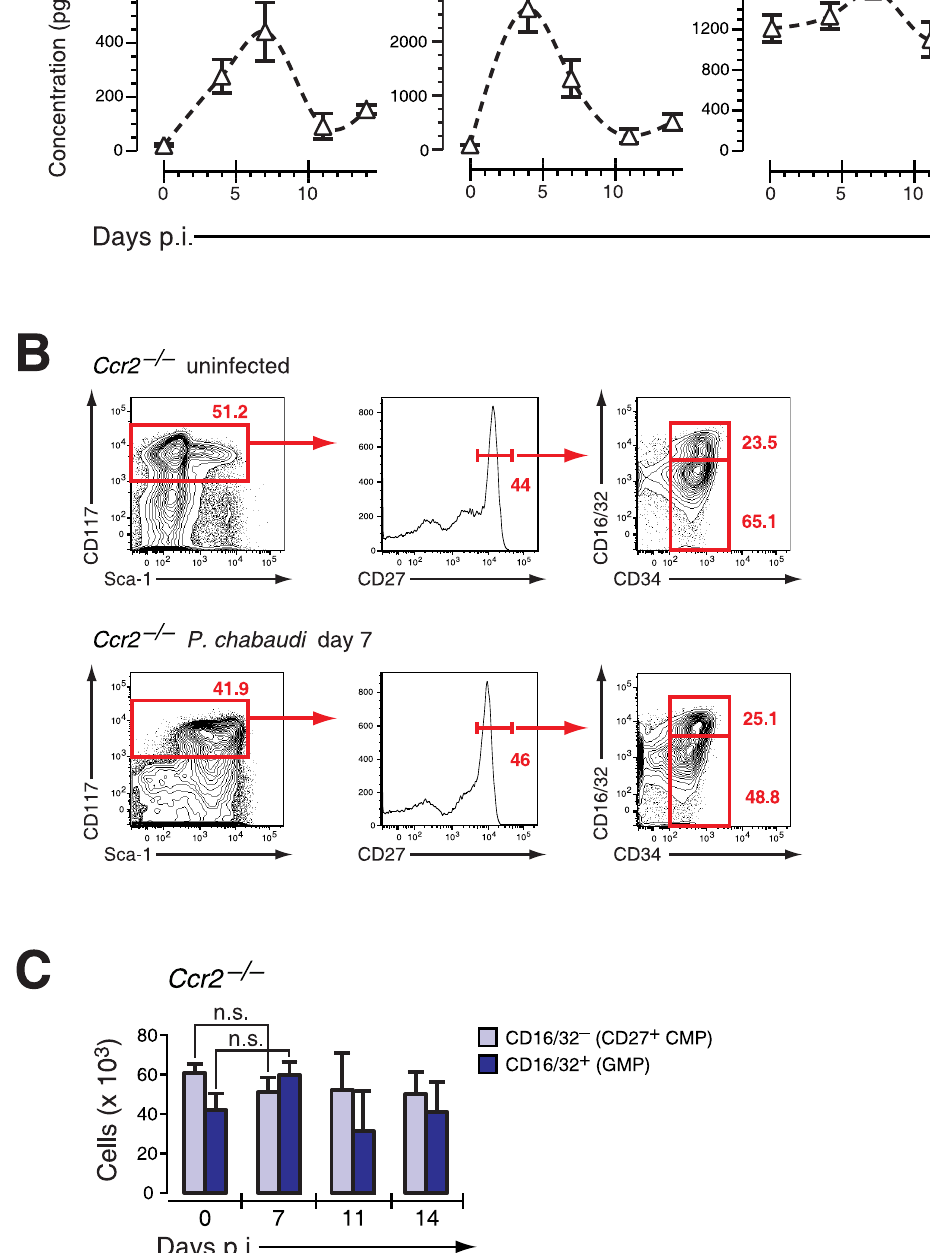
Figure 6. Ccr2 -null mice induce IFN- c -dependent chemokines but do not mobilize early myeloid progenitors. A. Serum concentration of IFN- c induced chemokines in Ccr2 -null mice infected with P. chabaudi . Data are shown as mean 6 SEM of serum concentration of respective chemokine in three infection experiments with 4–5 mice per each experimental group. B. Phenotype of LIN 2 BM cells in Ccr2 -null mice uninfected and at day 7 after infection with P. chabaudi stained for indicated marker. C. Absolute numbers (per femur/pair) for Ccr2 -null LIN 2 c-Kit hi CD27 + cells are shown as mean 6 SEM per individual subsets during infection with P. chabaudi . doi:10.1371/journal.ppat.1003406.g006 ratio of steady state, uninfected precursors to infected precursors observed splenomegaly comparable with the wild type controls. indicated that the mobilization of these subsets does not depend We also demonstrated that the combined absence of MyD88 and critically on the presence of TLR-signaling. In addition we also TRIF did not interfere with the upregulation of Sca-1 on HSCs